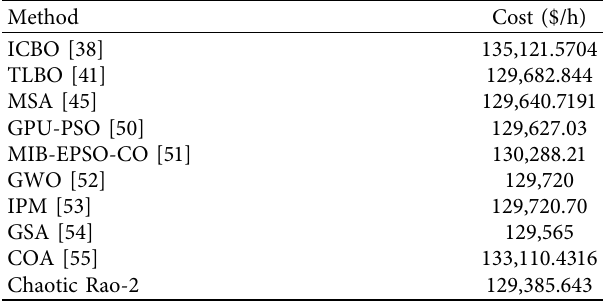
Table 10: Comparison of solutions accomplished for case 6.